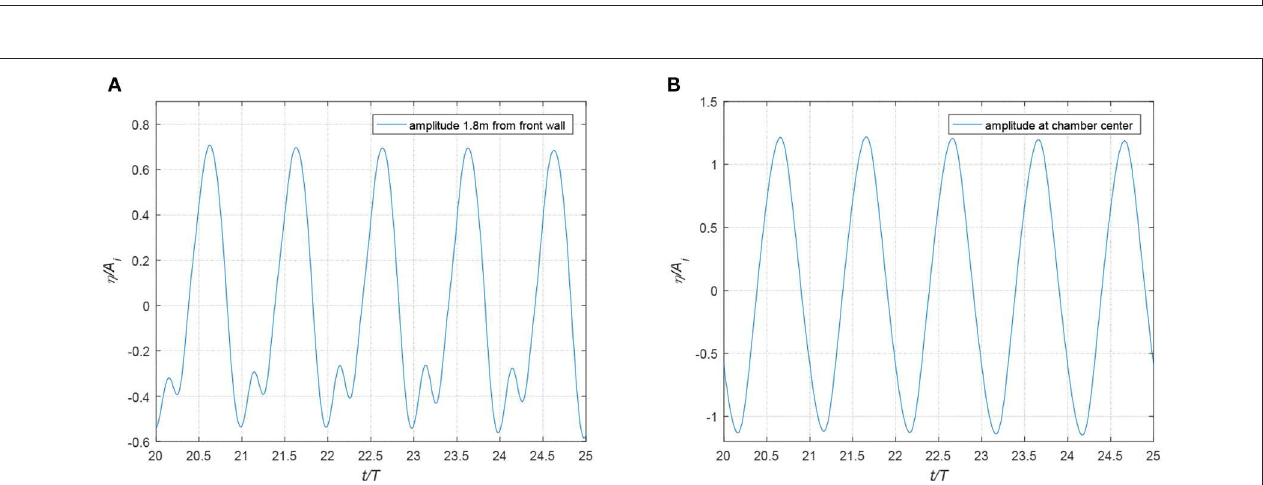
FIGURE 12 | Image of wave elevation along the wave flume at a/h = 0.21, b/B = 4. (A) Overall view (B) local view.